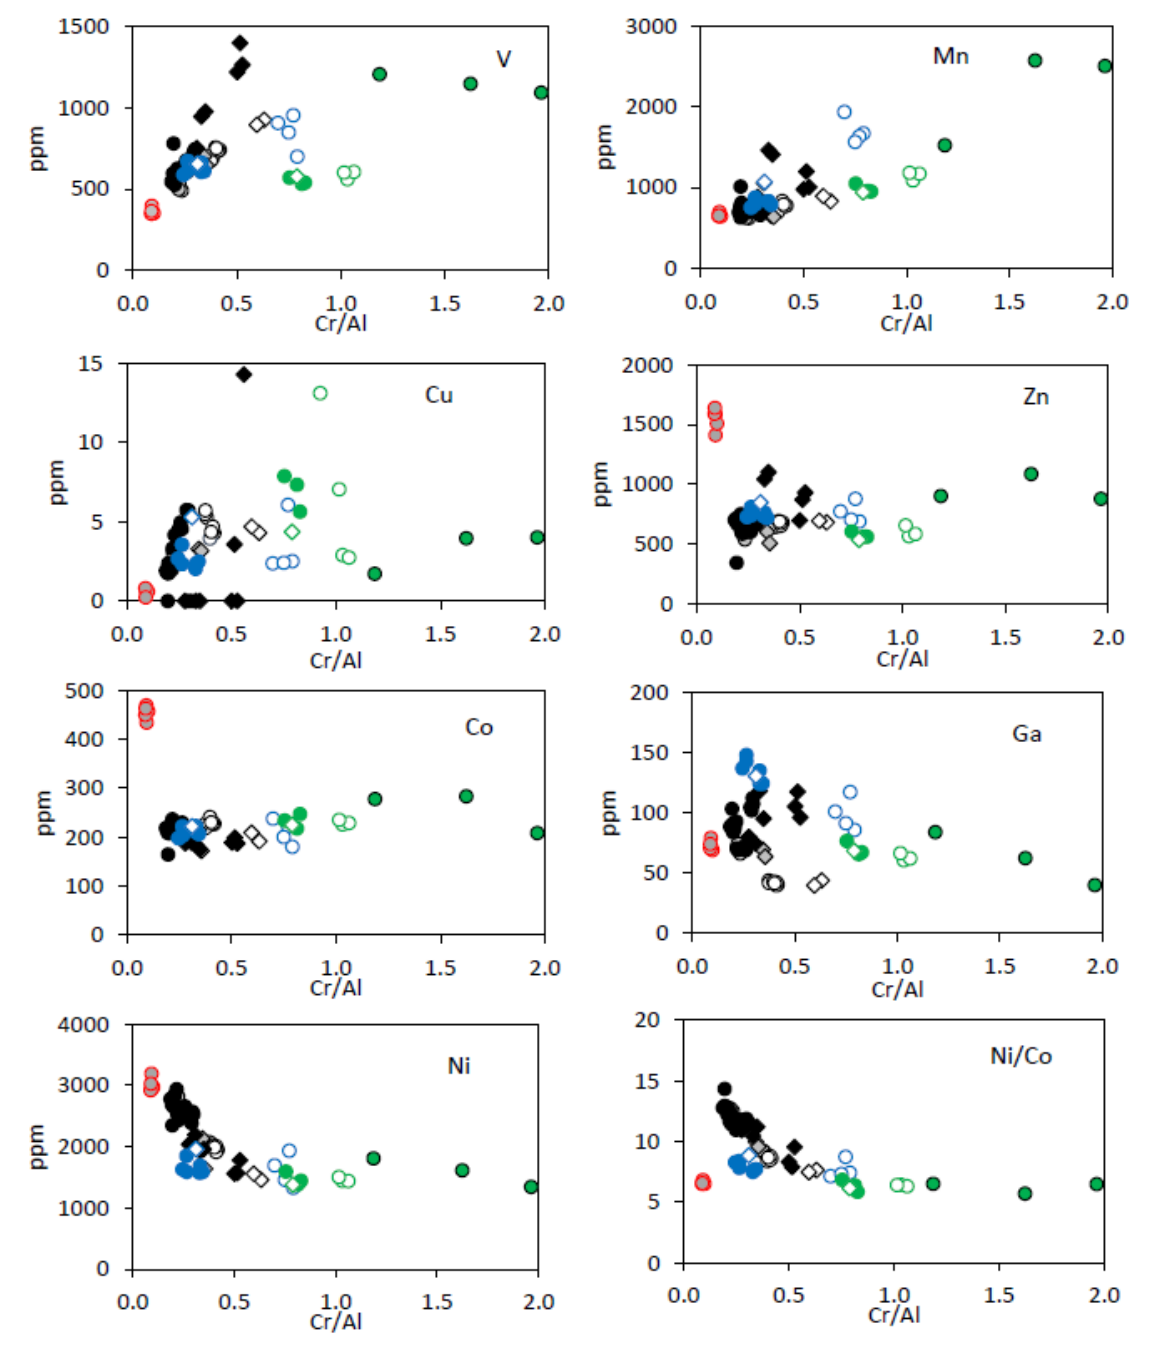
Figure 12. Plots of mantle spinel Cr/Al vs. various trace elements and Ni/Co from East Antarctic peridotite xenoliths. Symbols are as in Figure 9.